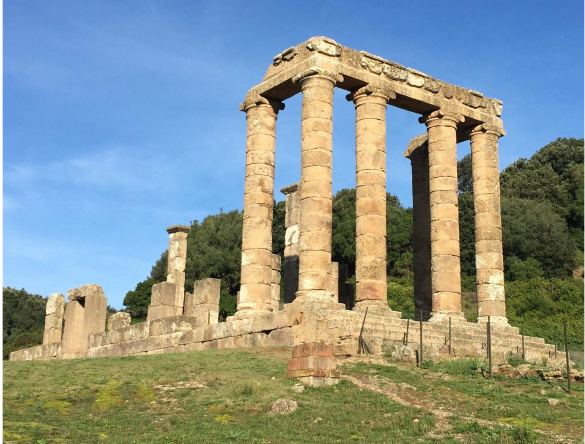
Figure 2. The pronaos of the temple of Antas (Fluminimaggiore, SU) .